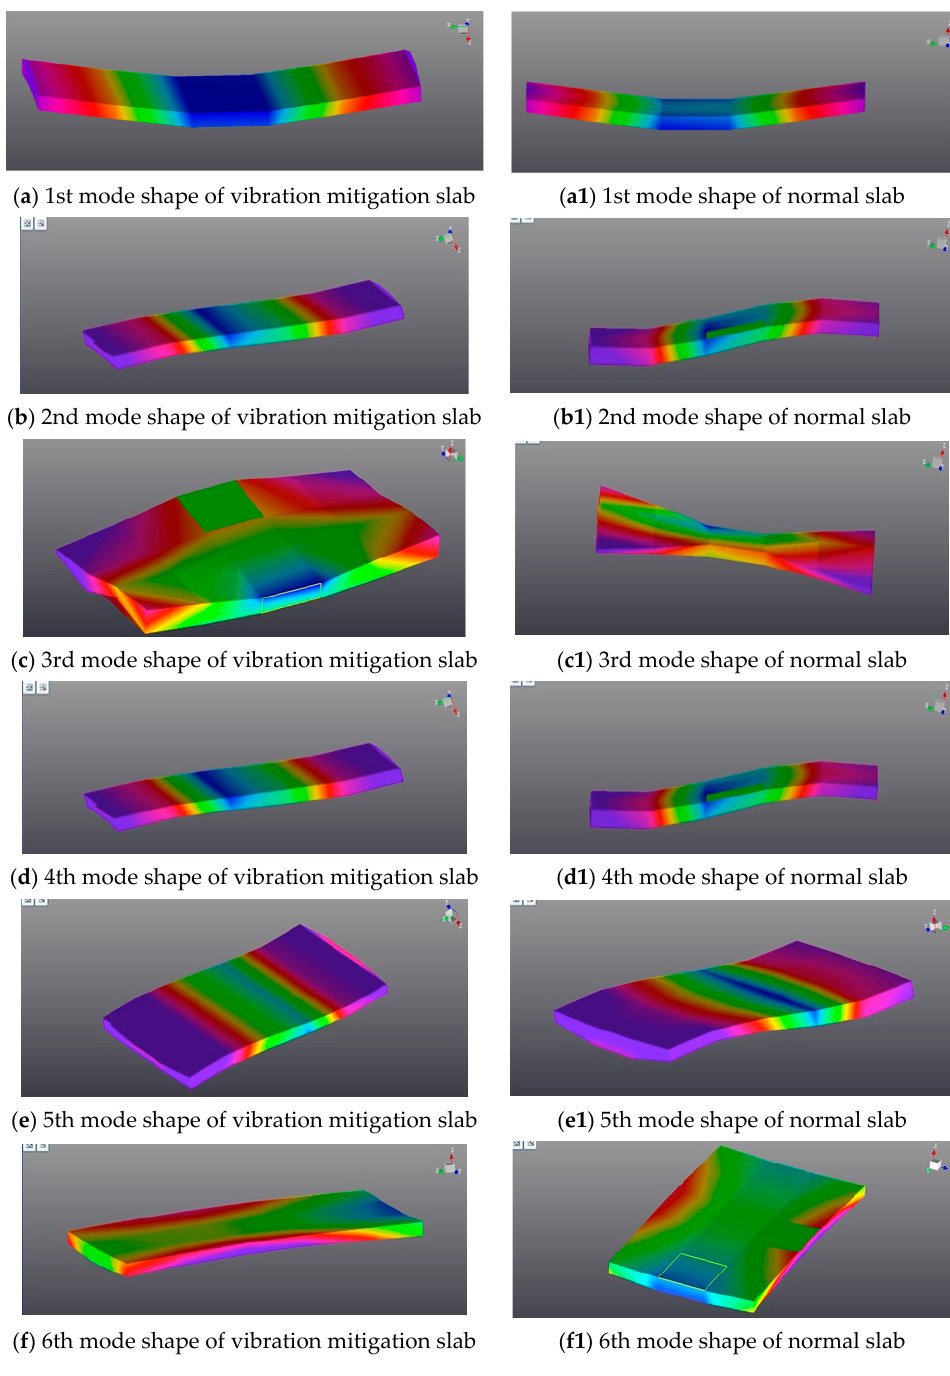
Figure 8. The comparison between rubber vibration mitigation slab and normal concrete slab.